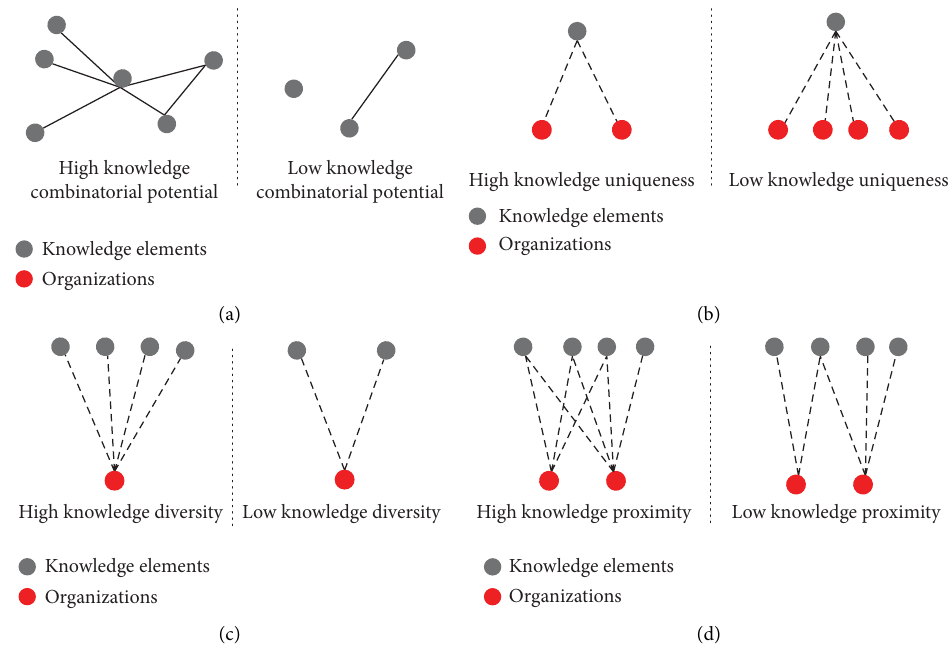
Figure 5: Graph explanation of these four knowledge attributes based on our multilevel network framework of Figure 2: (a) high and low knowledge combinatorial potential; (b) high and low knowledge uniqueness; (c) high and low knowledge diversity; (d) high and low knowledge